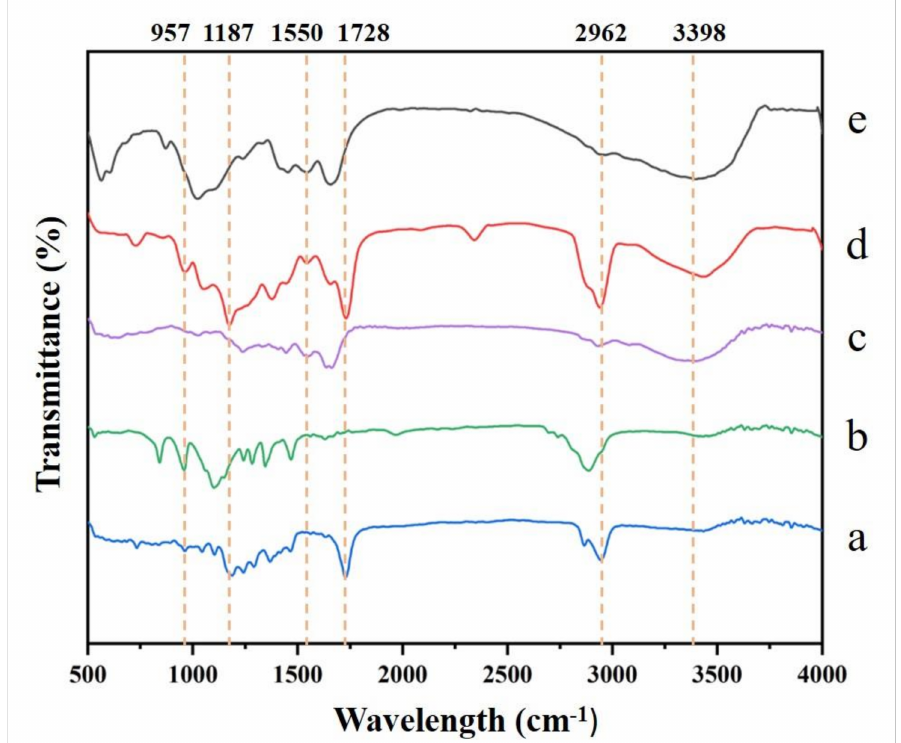
Figure 4. FTIR spectra of FC-PCL nanofiber membranes. ( a ) PCL, ( b ) PEO, ( c ) FC, ( d ) Before PEO removal, ( e ) After PEO